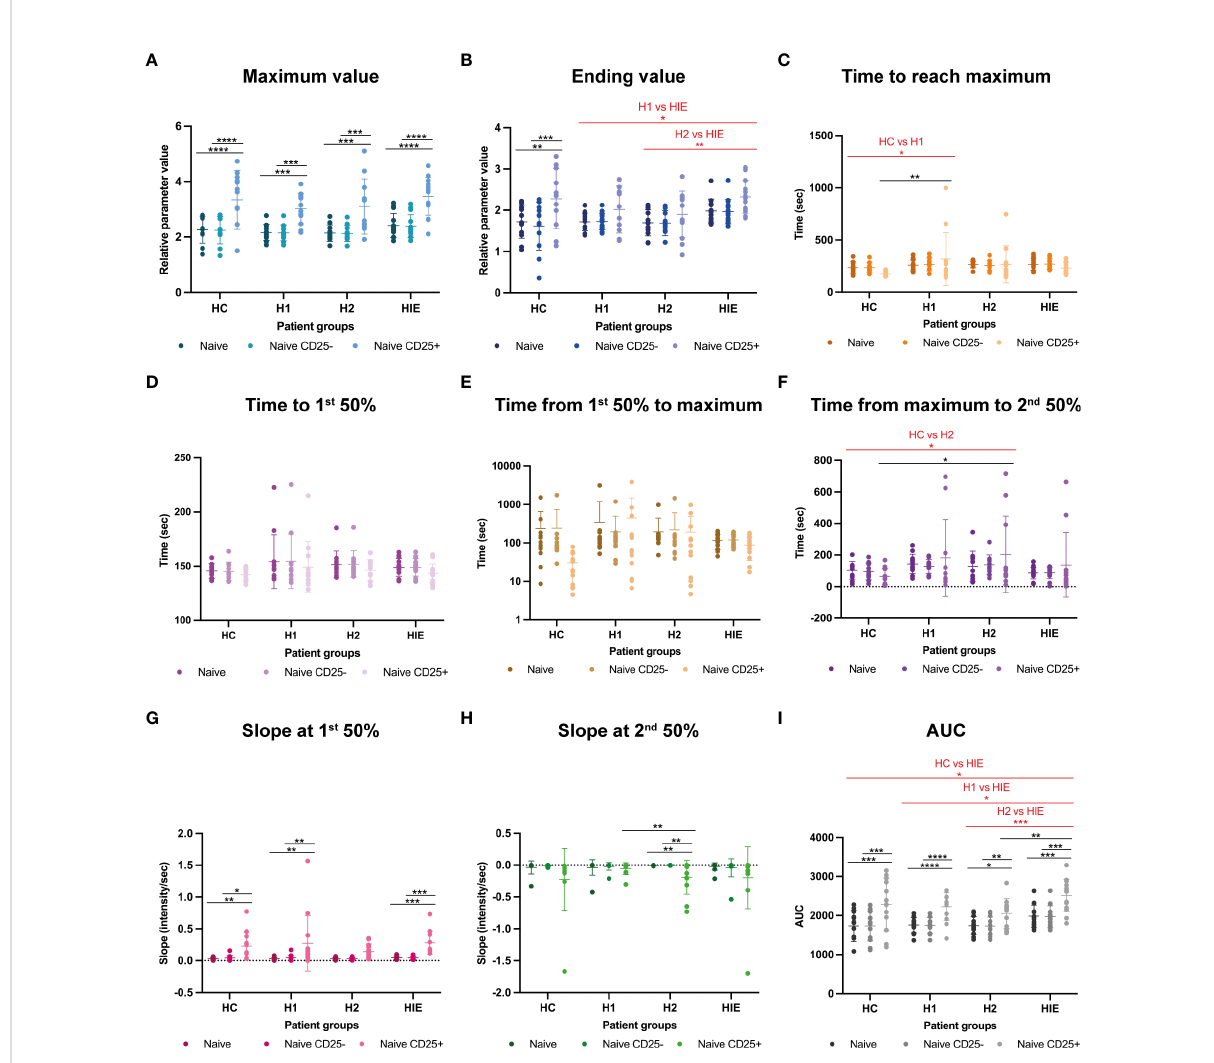
FIGURE 4 Naive B cells show higher Ca 2+ signal upon BCR stimulation in ATA+ euthyroid, infertile patients Calcium fl ux kinetic data of naive B, naive CD25- and naive CD25+ B cells (A) maximum value, (B) ending value, (C) time to reach maximum, (D) time to fi rst 50% value, (E) time from fi rst 50% to maximum, (F) time from maximum to second 50% value, (G) slope at the fi rst 50% value, (H) slope at second 50% value, (I) area under curve (AUC) value. HC: healthy controls (n=12); HT: Hashimoto ’ s thyroiditis, H1: hypothyroid patients with HT before treatment (n=14); H2: euthyroid patients with HT, after levothyroxine-treatment, (n=12); HIE: HT, infertile, euthyroid patients (n=14); NSw: non-switched; Sw: switched, DN: double negative memory B cells. The kinetic data were analyzed by the FACSKin software. Differences between the groups were assessed with two-way ANOVA and Tukey ’ s post hoc test except H1-H2 comparisons where a mixed-effects analysis and the Tukey ’ s multiple comparisons test were used because these groups represent the same individuals in a repeated sampling before and during treatment. Data are depicted as individual values, middle line represents the mean, whiskers are set to standard deviation (SD) *p < 0.05, **p < 0.01, ***p < 0.001, ****p <